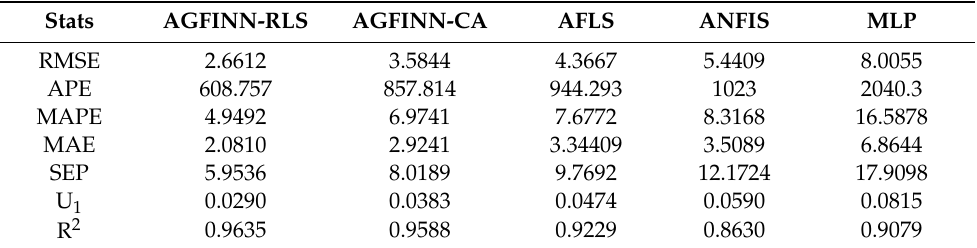
Table 6. Statistical performances for electricity price forecasting models at 04:00—case study 3.